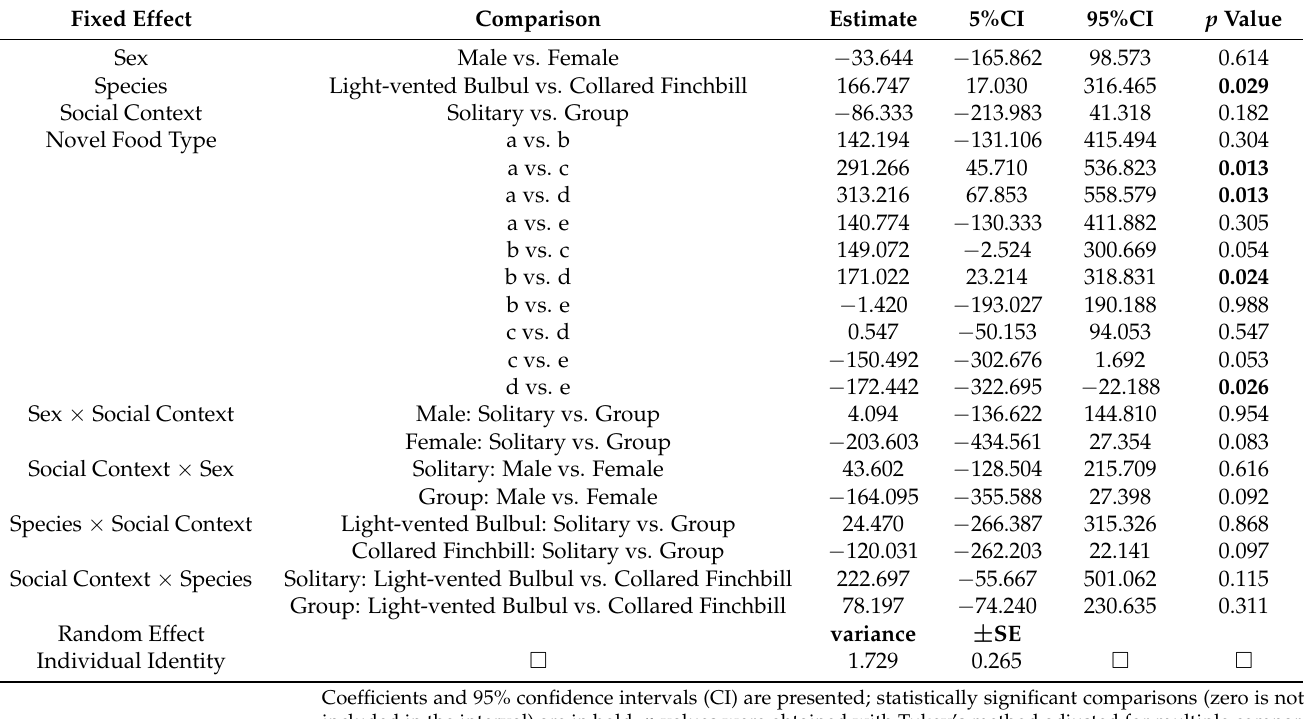
Table 2. Effects of fixed factors on time to start eating novel food (t1) for solitary and group Light- vented Bulbuls and Collared Finchbills.